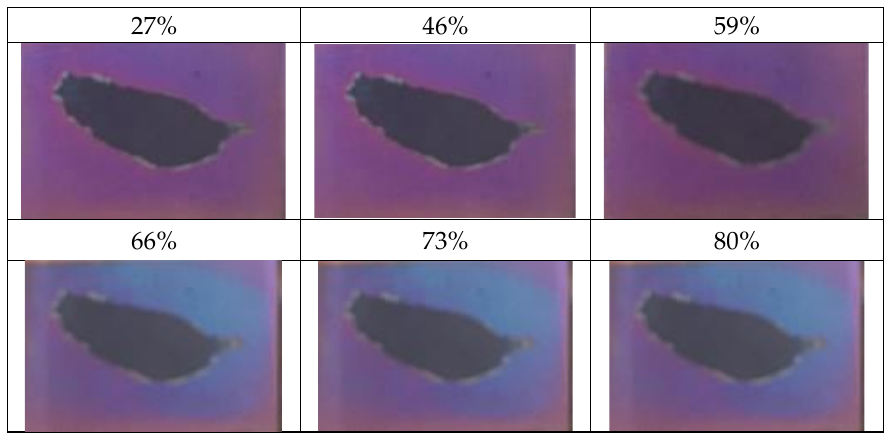
Figure 14. Optical AAO humidity sensor.